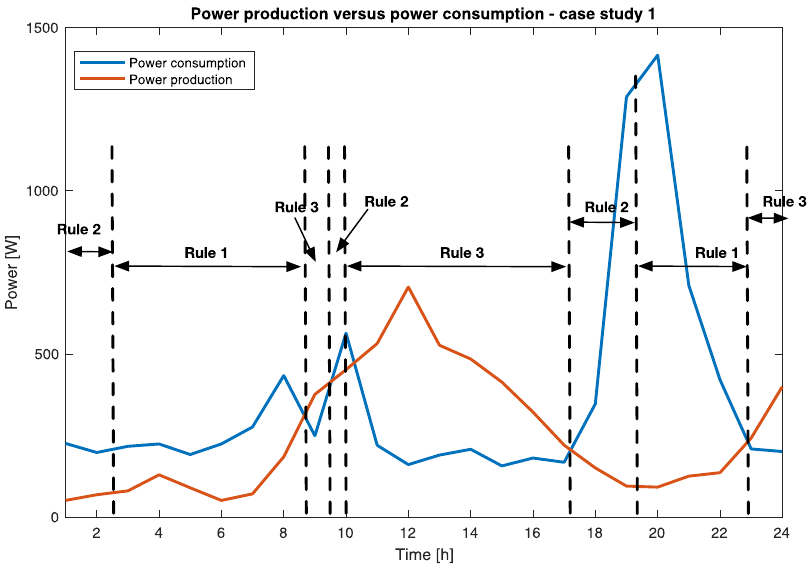
Figure 14. Load–generation curves: case study 1.